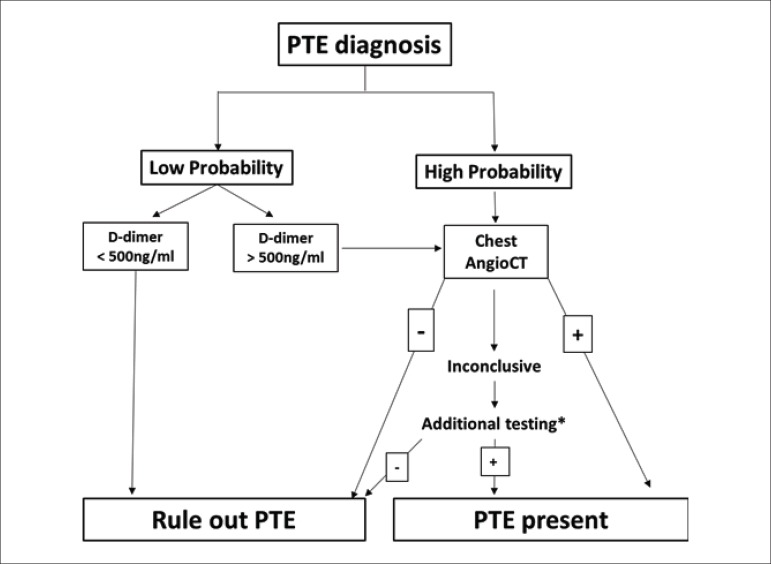
Flowchart for the diagnosis of PTEPTE: pulmonary thromboembolism; Chest AngioCT: computed
tomography angiography of the chest. * Ventilation/perfusion
scintigraphy; contrasted pulmonary angiotomography; serial
Doppler of lower limbs; pulmonary angiography by nuclear
magnetic resonance.